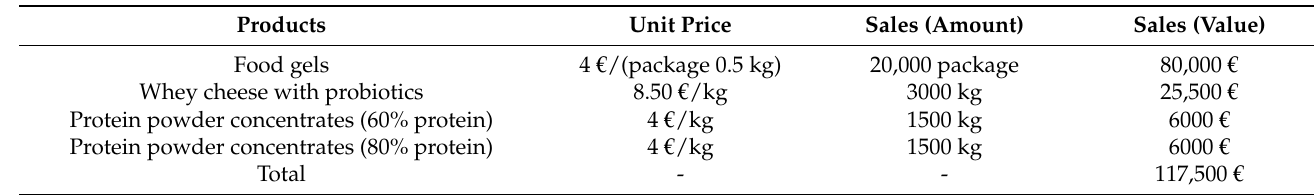
Table 5. Annual sales